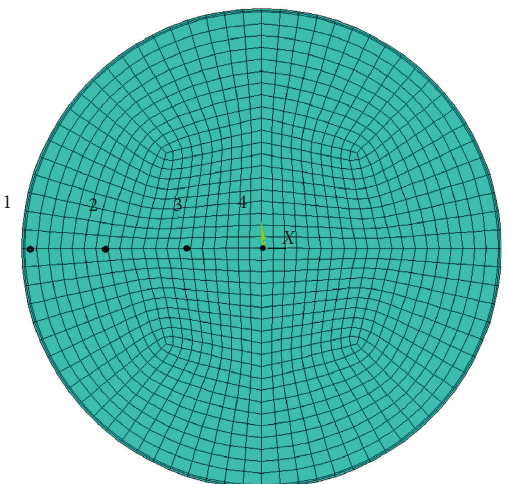
Figure 6: Finite element model and measuring-point locations.